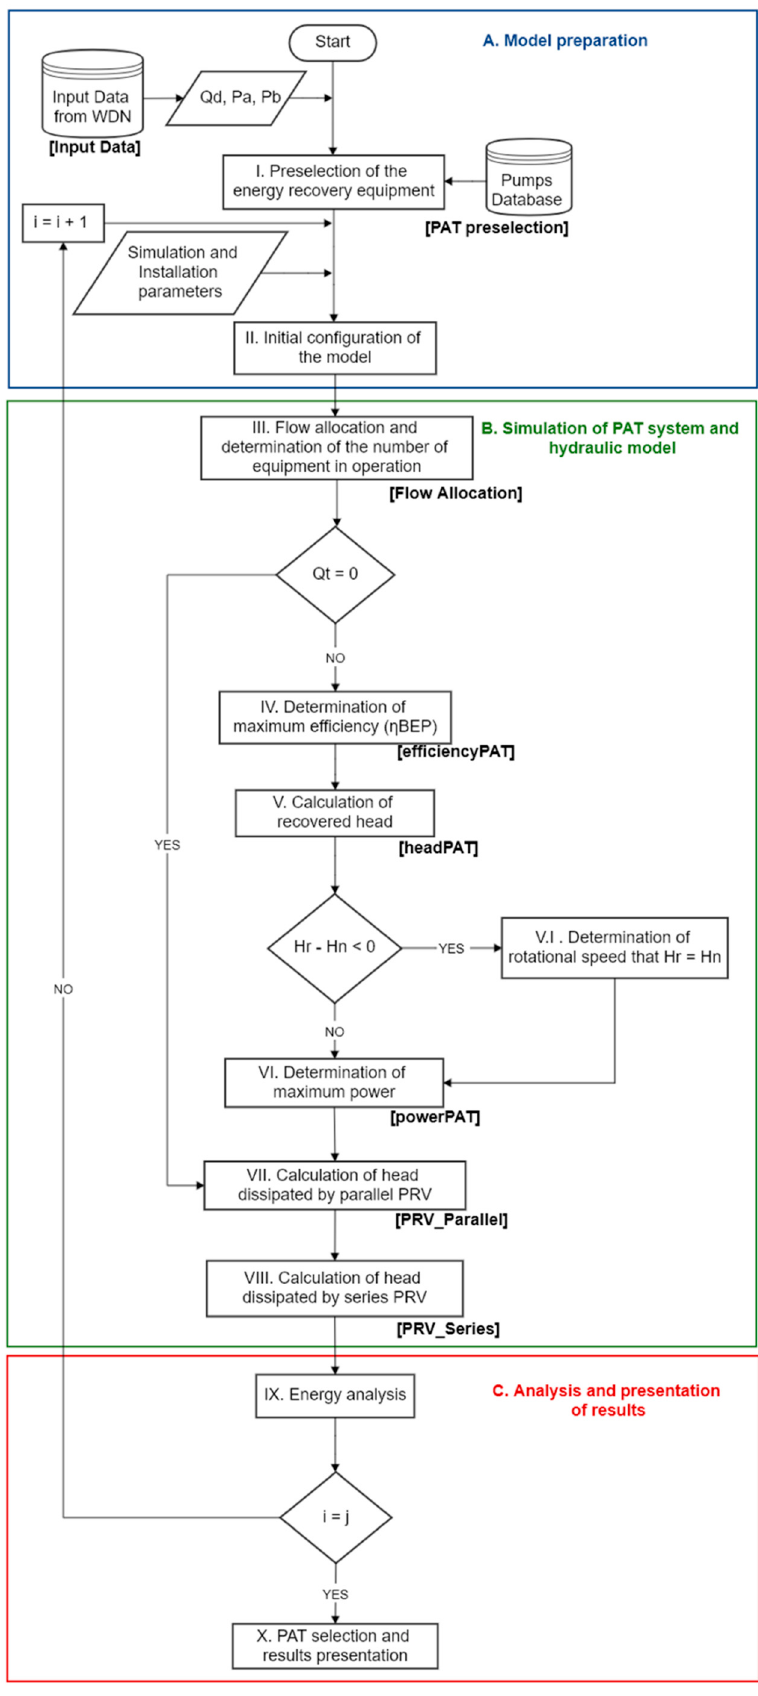
Figure 2. Proposed methodology for the analysis of the regulation in an energy-recovery system.